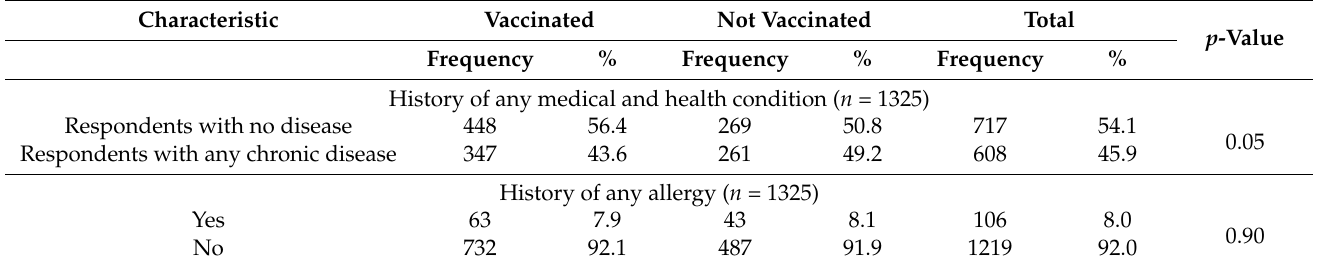
Table 3. History of any medical/health condition and any allergy among respondents ( n = 1325).